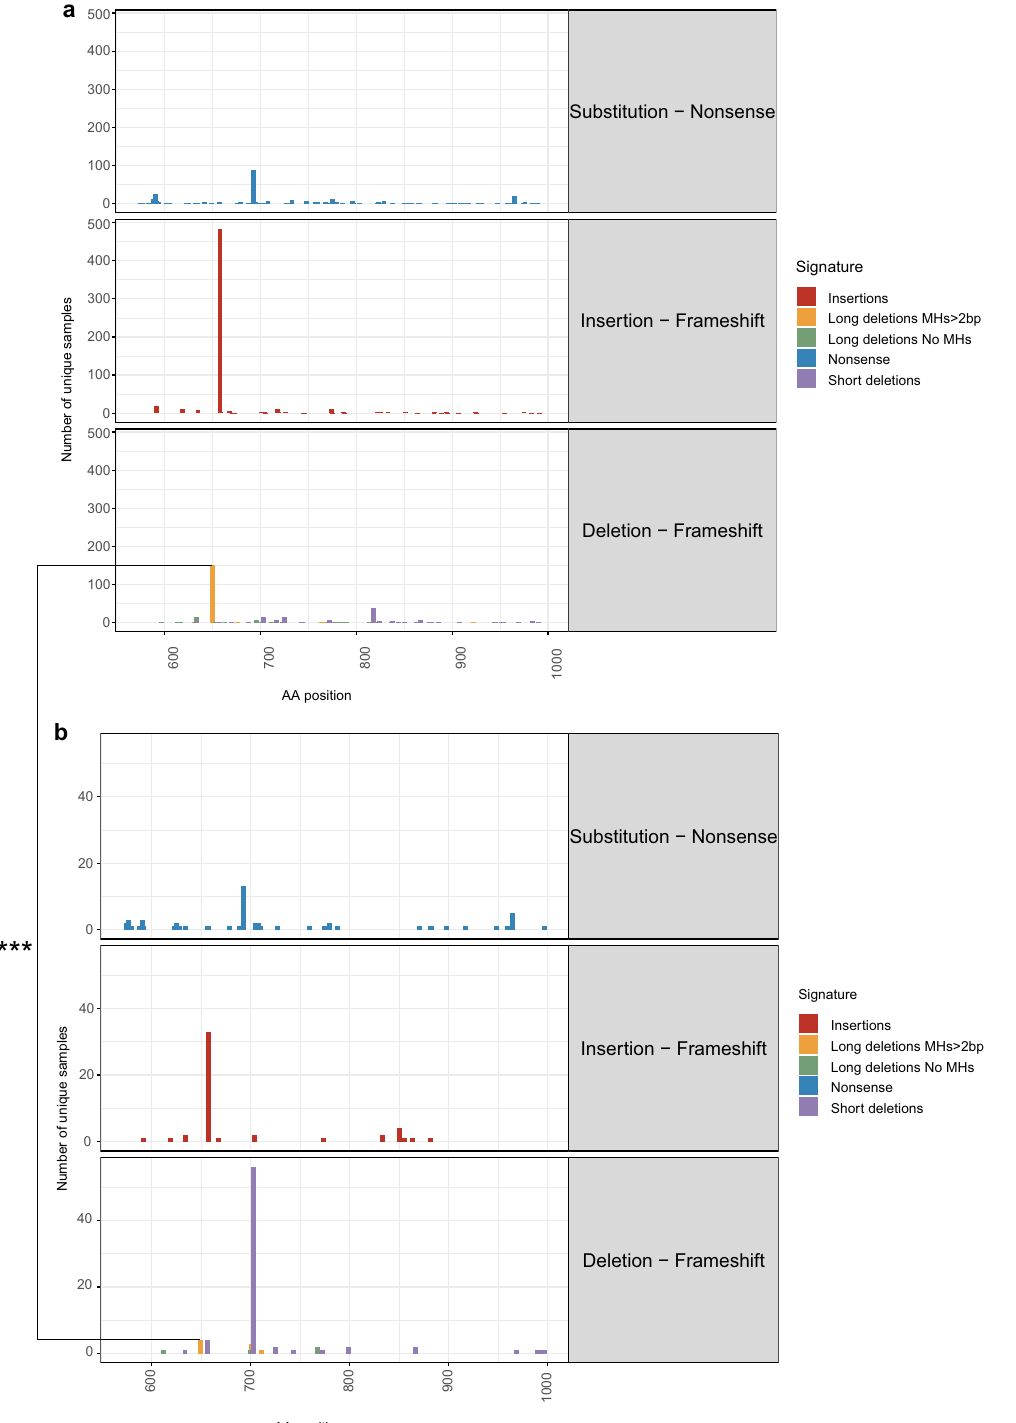
Fig. 2 High recurrence rates of ASXL1 MH-based deletion in myeloid malignancies are driven by speci fi c mutational mechanisms. a , b Number of samples carrying somatic truncating mutations in ASXL1 gene and the position of the last amino acid of ASXL1 protein (AA position) as identi fi ed across n = 1434 hematologic ( a ) and n = 252 non-hematologic ( b ) tumors in COSMIC dataset. Deletions signatures are Nonsense substitutions (blue), frameshift insertions (red), frameshift ≥ 5-bp deletions with fl anking microhomologies (MHs) of at least 2 bp (orange), frameshift ≥ 5-bp deletions with fl anking MHs of zero or 1 bp (green) and frameshift short deletions (<5-bp) (purple). The proportions of MH-based deletion cases (orange) out of the total deletion cases (purple, green and orange) were compared between hematologic (153/376) and non-hematologic (4/103) tumors. Chi squared test with yates correction for continuity was used to determine statistical signi fi cance. (**** p = 4.136e-12). Source data are provided as a Source Data fi